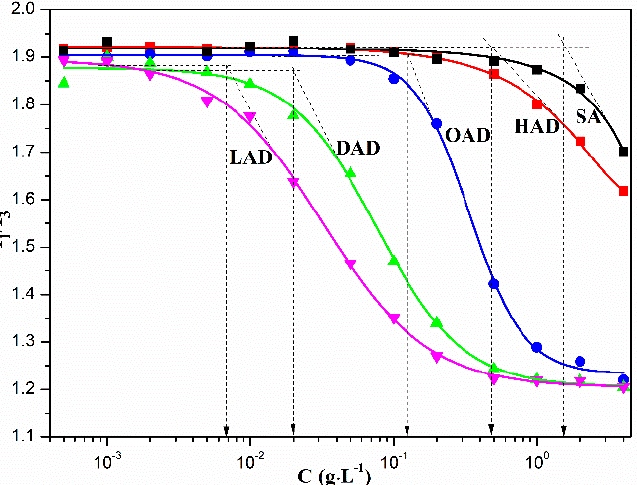
Figure 5. Plots of pyrene fluorescence intensity I 1 /I 3 vs. the concentration of SA, HAD, OAD, DAD, and LAD in aqueous NaCl